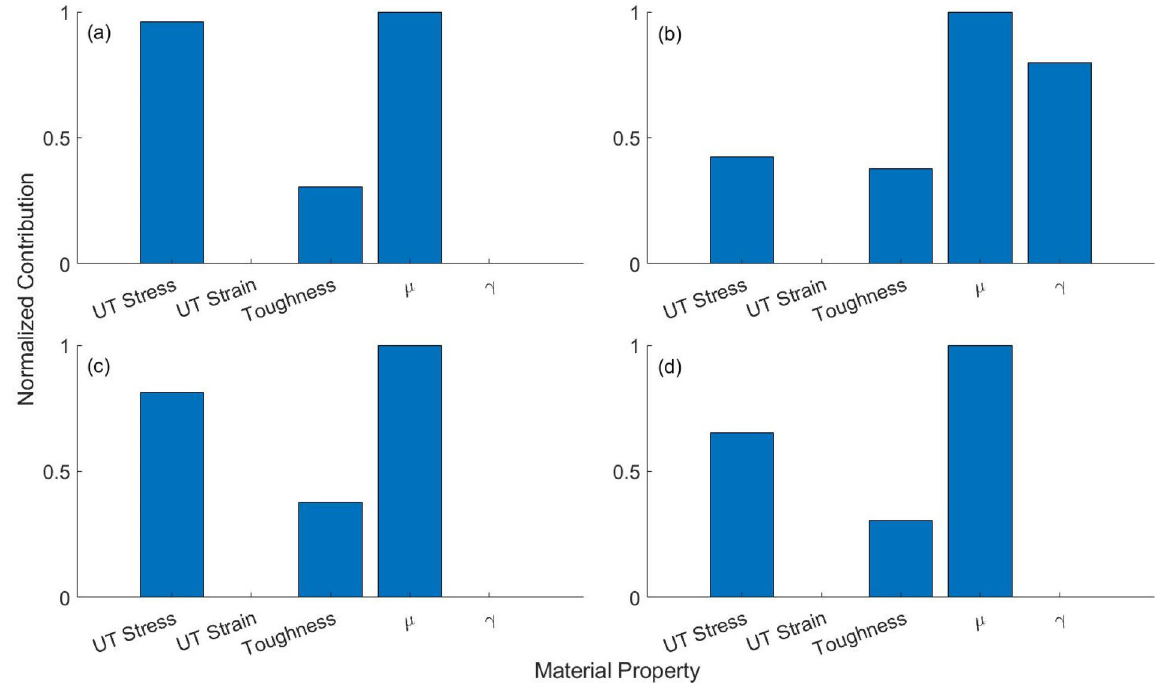
Figure 3. Contribution of each of the five material properties in the binary classification of full thickness burned human and porcine skin tissue samples under loading rate of ( a ) 0.3 mm/s, ( b ) 2 mm/s, ( c ) 8 mm/s, ( d ) all three loading rates